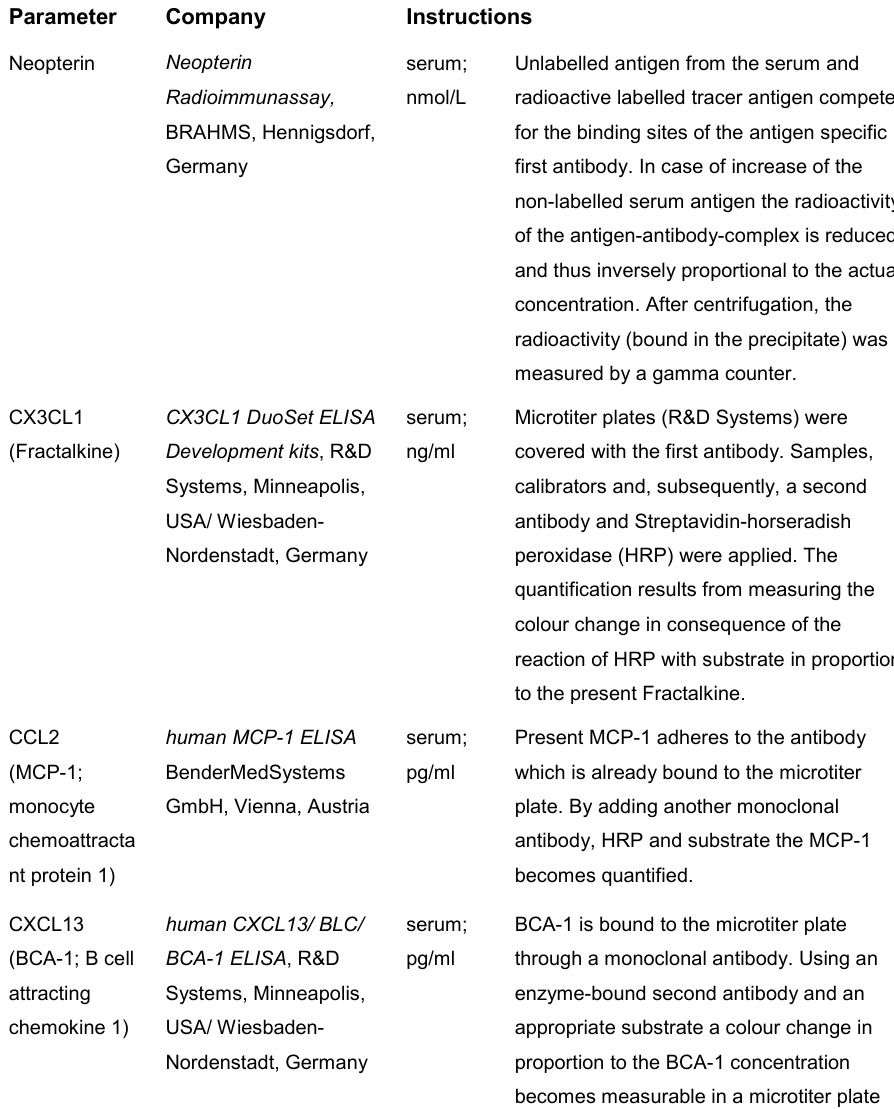
Table 1: Immunoassays used for measurement of neopterin, CX3CL1, CXCL13 and CCL2: